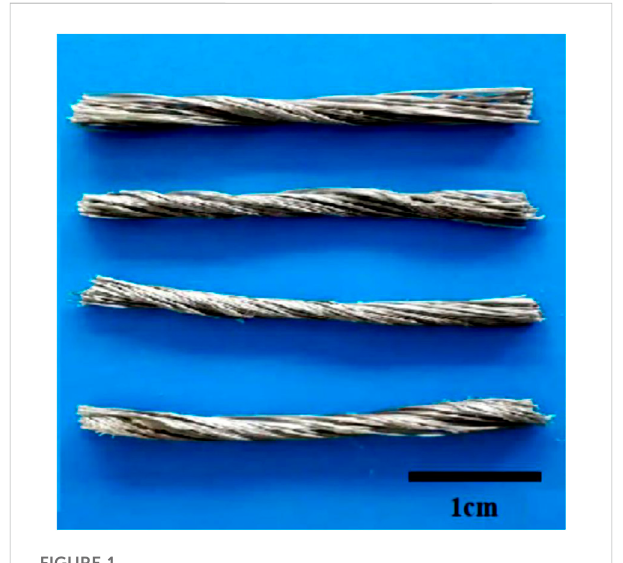
FIGURE 1 Synthetic twisted bundle macro- fi bers (SF) of 35 mm in length.